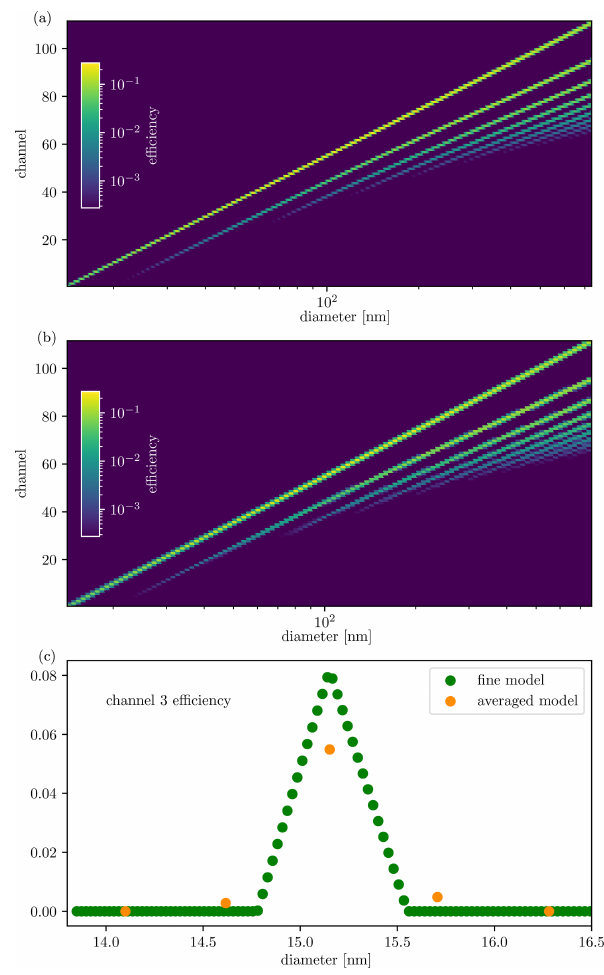
Figure 2. The size distribution transfer functions for (a) simulating the measurement data, and (b) the observation model used in state estimation. In the images, the horizontal axis corresponds to the size of the particle entering the device, and the vertical axis represents the channels of the SMPS. The colors represent the values of the efficiency with which a given particle size will be classified in a given bin in the particle